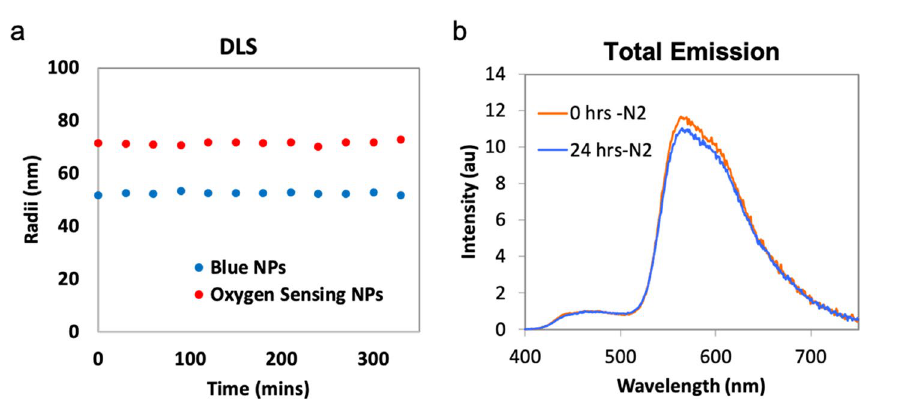
Figure 2. The stability of NPs. ( a ) DLS traces for NPs. The radii were recorded every 30 min. ( b ) The stable oxygen-sensing ability of NPs was confirmed by measuring the emission before and after incubation at 37 °C for 24